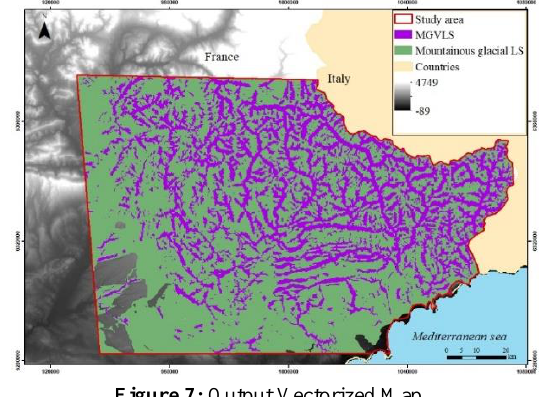
Figure 7: Output Vectorized